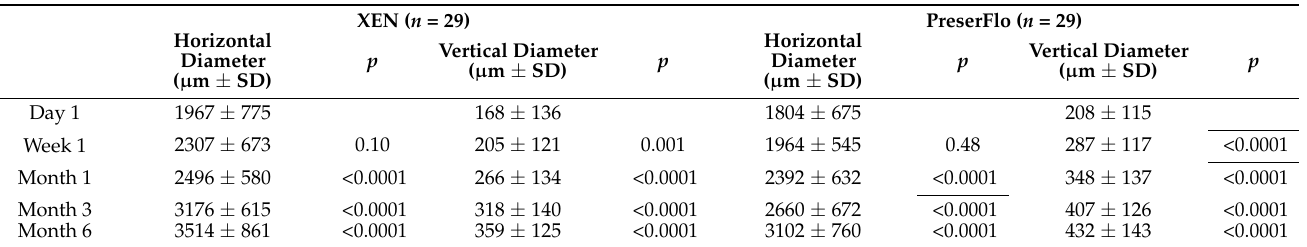
Table 4. Horizontal and vertical bleb diameters after XEN and PreserFlo implantation at day 1, week 1, month 1, month 3 and month 6 follow